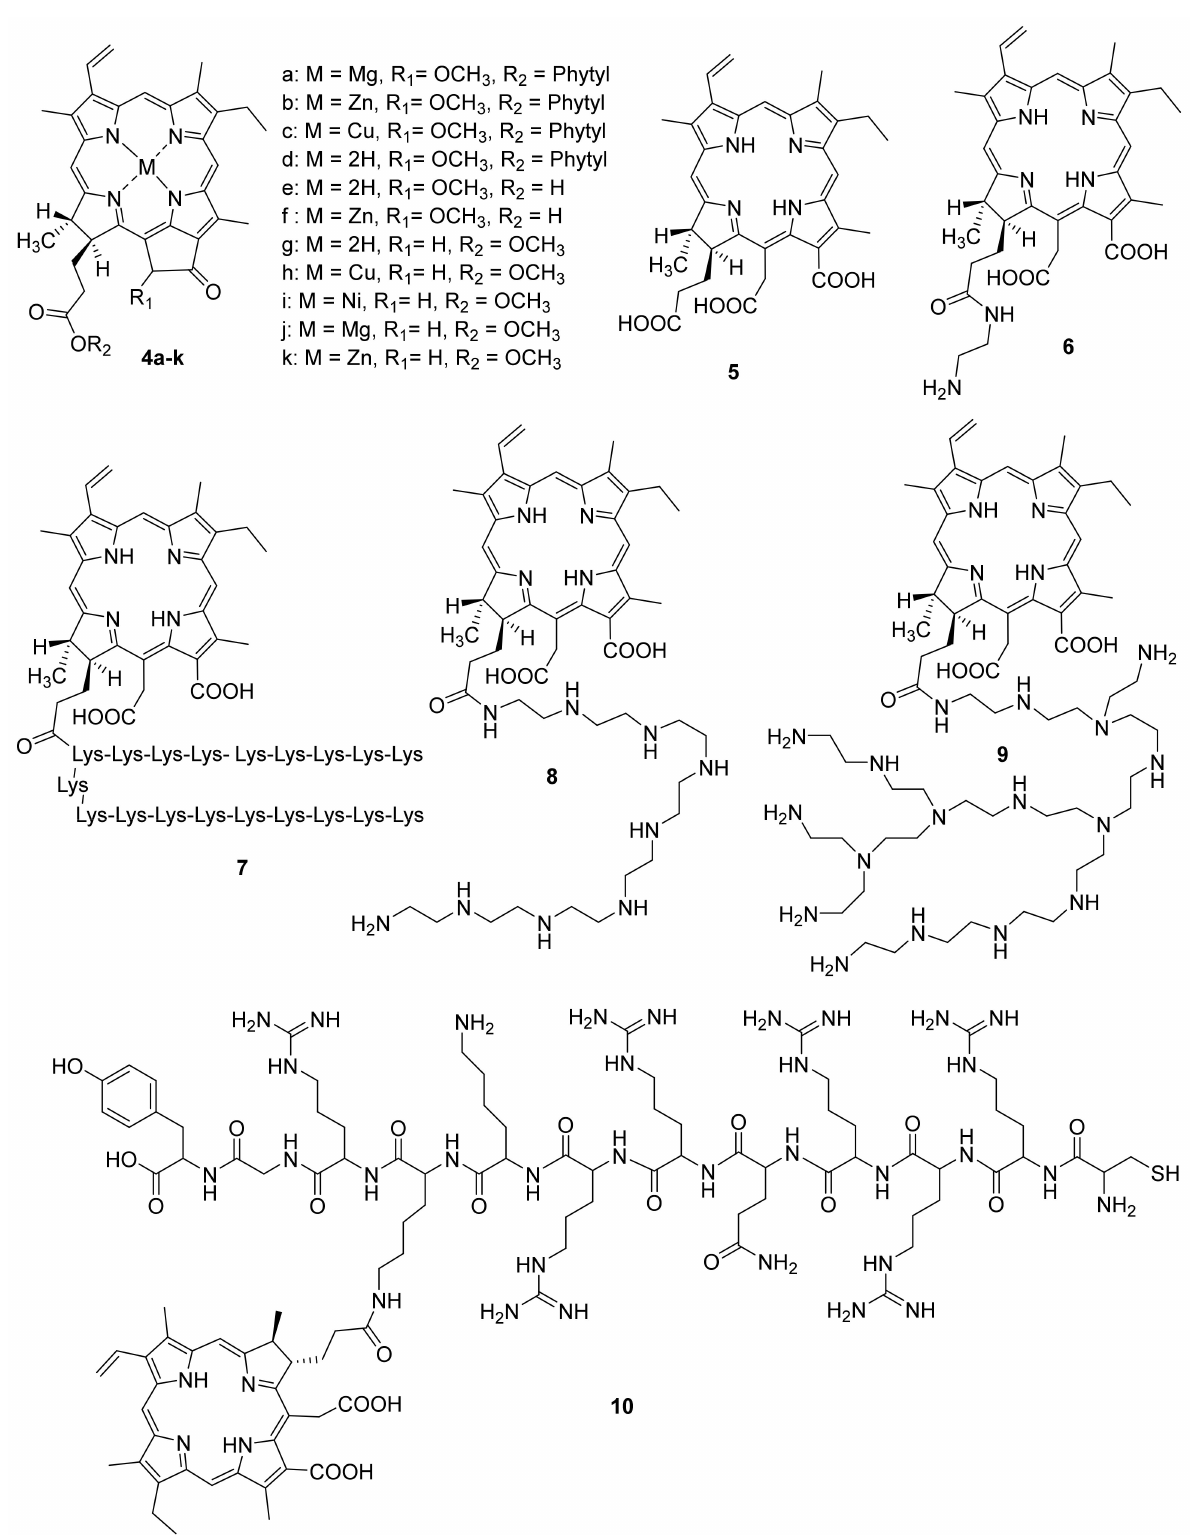
Figure 2. Chlorophyll a derivatives used in antimicrobial